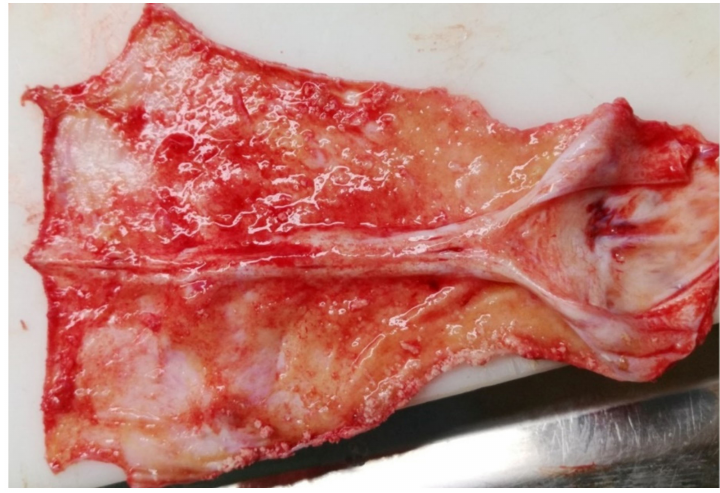
Figure 6. Wapiti, case 2, visceral surface of dura mater, gross pathology. Severe diffuse chronic proliferative and still active acute serofibrinous pachymeningitis.